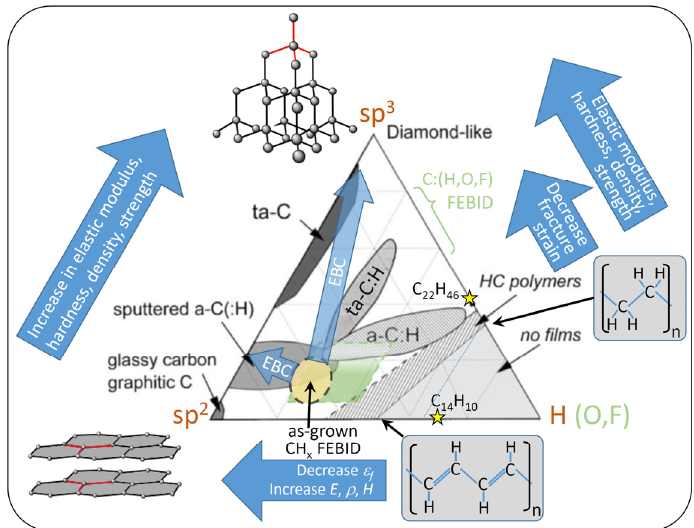
Figure 10. The ternary phase diagram of carbon materials with varying sp 2 , sp 3 , and hydrogen contents. Modified from Robertson [92] . The acronyms are amorphous carbon (a-C), tetrahedrally coordinated amorphous carbon (ta-C), amorphous hydrogenated carbon (a-C:H), and tetrahedrally coordinated amorphous hydrogenated carbon (ta-C:H). HC stands for hydrocarbon. Structural formulae are given for polyethylene and polyacetylene, sum formulae are given for para ffi n and phenanthrene FEBID / FIBID precursors. Trends in mechanical properties are indicated by arrows as well as changes in composition during electron beam curing (EBC). The as-grown CH x -FEBID material space according to measurements from Bret et al. [93] and Ding et al. [45] is indicated (yellow shade) as well as the anticipated space for C:(H,O,F) FEBID (and FIBID) matrix material (green shade). No data are available for FIBID material.